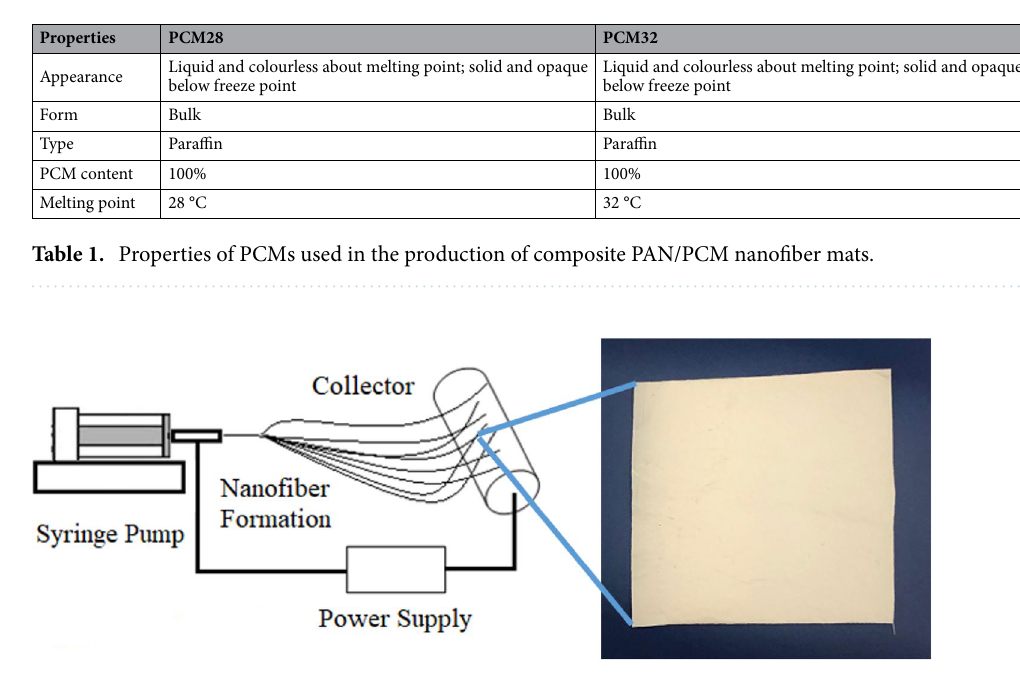
Figure 1. Schematic of the electrospinning setup used in the production of the composite PAN/PCM nanofibers and photograph of composite PAN nanofibers with 50% PCMs